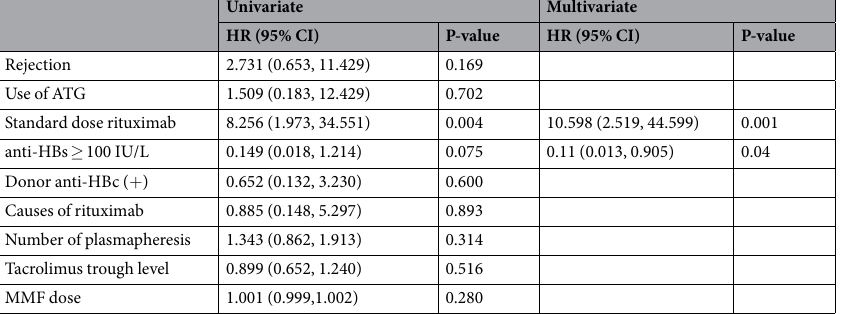
Table 3. Risk factors for HBV reactivation.